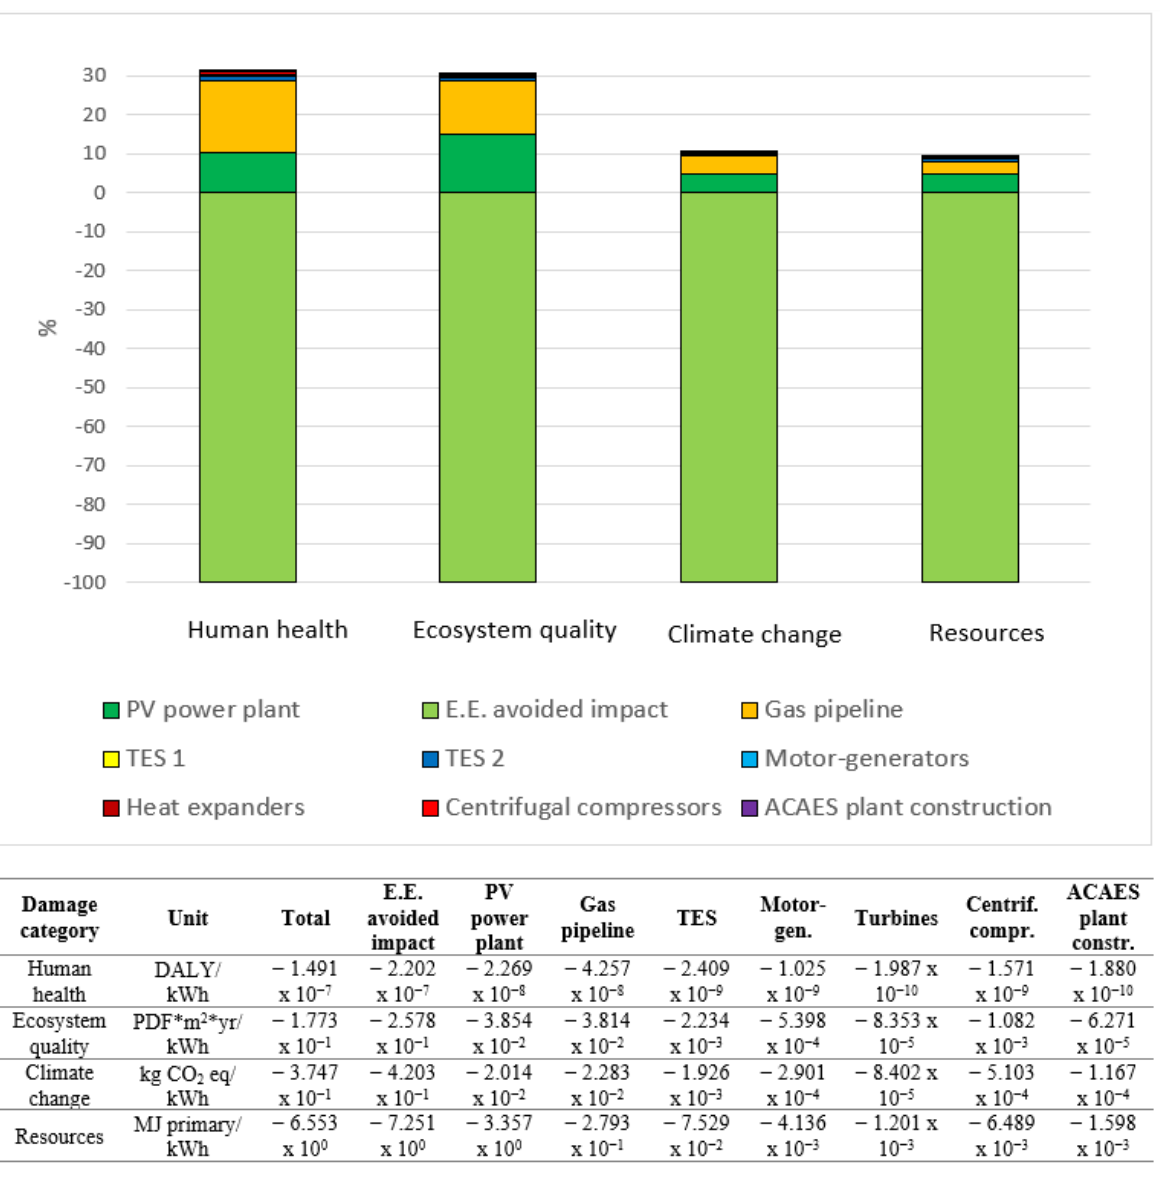
Figure 11. Impact categories for the main components of the PV-ACAES plant with air storage in a gas pipeline, for configuration C3. Table 5. Results for the best